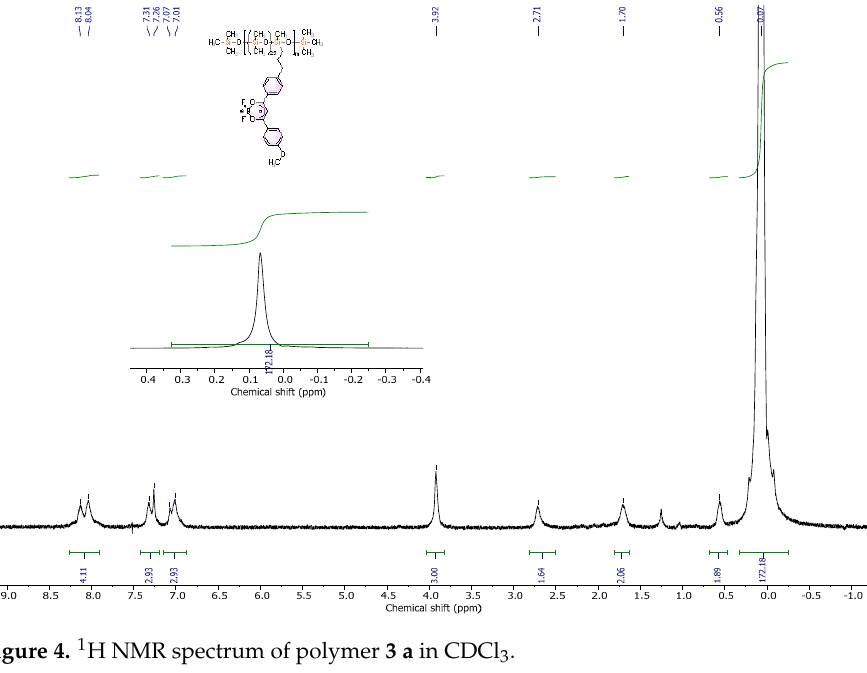
Figure 4. 1 H NMR spectrum of polymer 3 a in CDCl 3 . Polymers 2022 , 14 , x FOR PEER REVIEW